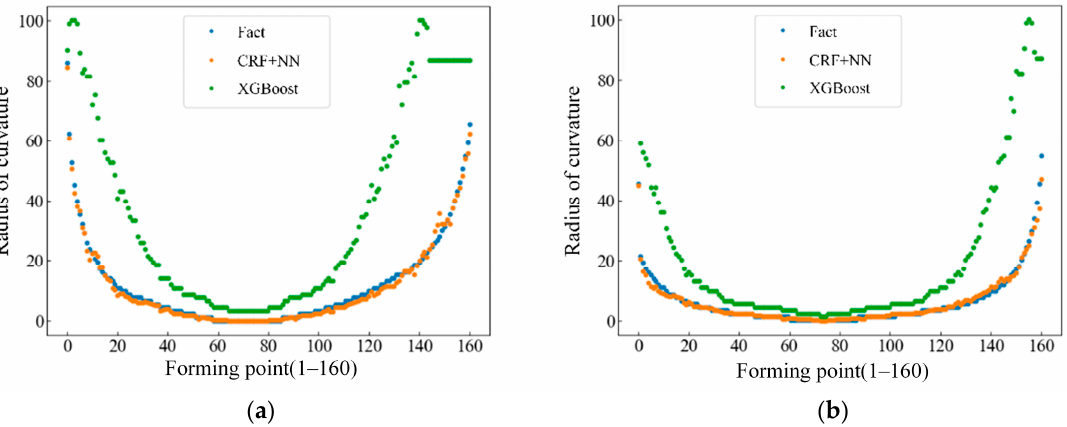
Figure 13. Contrast experiment between fixed-curvature model and variable-curvature model. ( a ) Experiment No.1; ( b ) Experiment No.2.